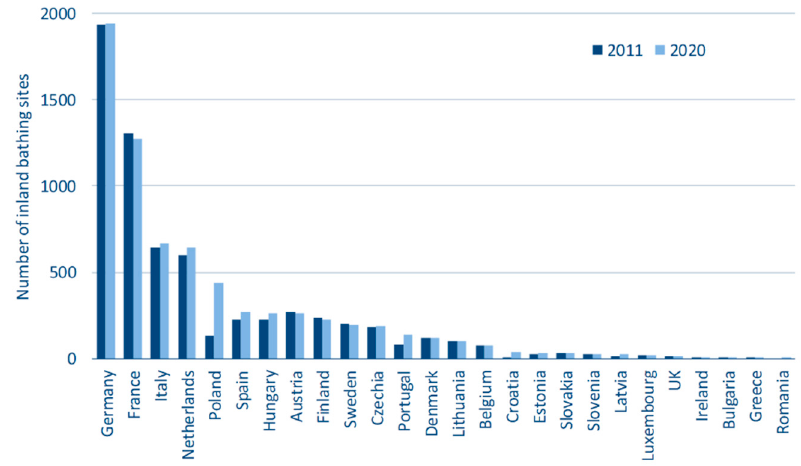
Figure 2. The number of inland bathing sites in the EU in the 2011 and 2020 bathing season.